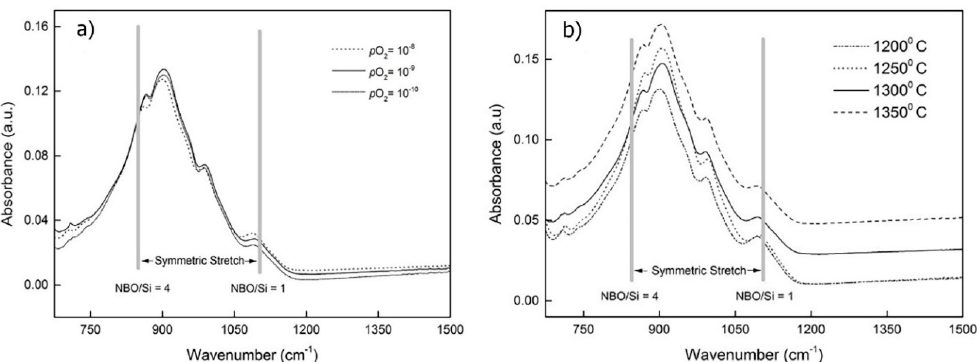
Figure 9. FTIR spectra of equilibrated FCSM-Cu 2 O-PdO slags ( a ) at different p O 2 at 1300 °C and ( b ) at different temperatures at p O 2 = 10 − 8 atm.